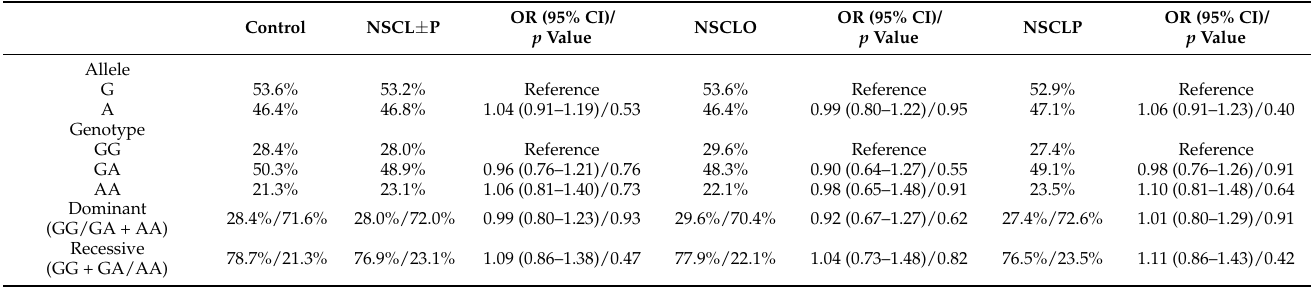
Table 4. Association between MMP2 rs243836 and the risk of nonsyndromic cleft lip with or without cleft palate (NSCL ± P), nonsyndromic cleft lip only (NSCLO) and nonsyndromic cleft lip and palate (NSCLP). p values were adjusted for covariates by logistic regression